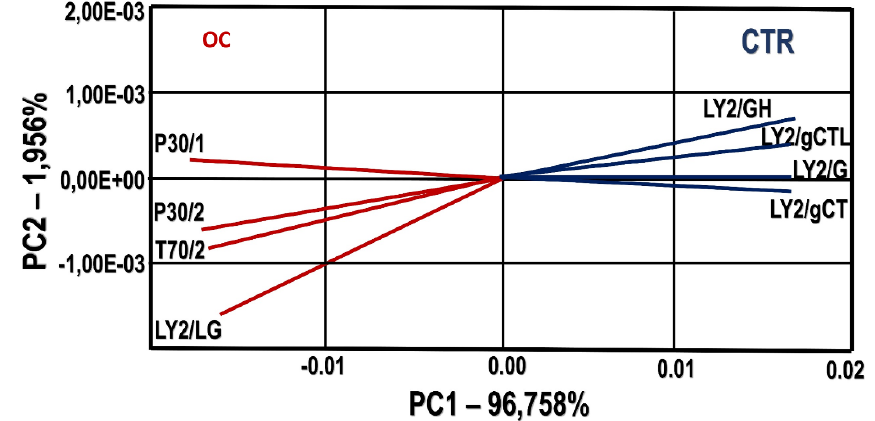
Figure 3. Principal Components Analysis (PCA) with the loading of selected sensors for the cheese samples. CTR group: five cheese wheels after 60 days of ripening obtained from the milk of dairy cows fed concentrate without olive cake supplements. OC group: five cheese wheels after 60 days of ripening obtained from the milk of dairy cows fed concentrate with olive cake supplements. LY2/GH, LY2/gCTL, LY2/gCT, LY2/G are the selected sensors involved for CTR group and LY2/LG, P30/1, T70/2, P30/2 are the selected sensors involved for OC group. Discrimination index = 74. The two principal components (PC1 and PC2) are responsible for 98.71% of the variation showed by sensor’s signals used as loadings. The loading length of a trait measures the magnitude of its effect (positive or negative).